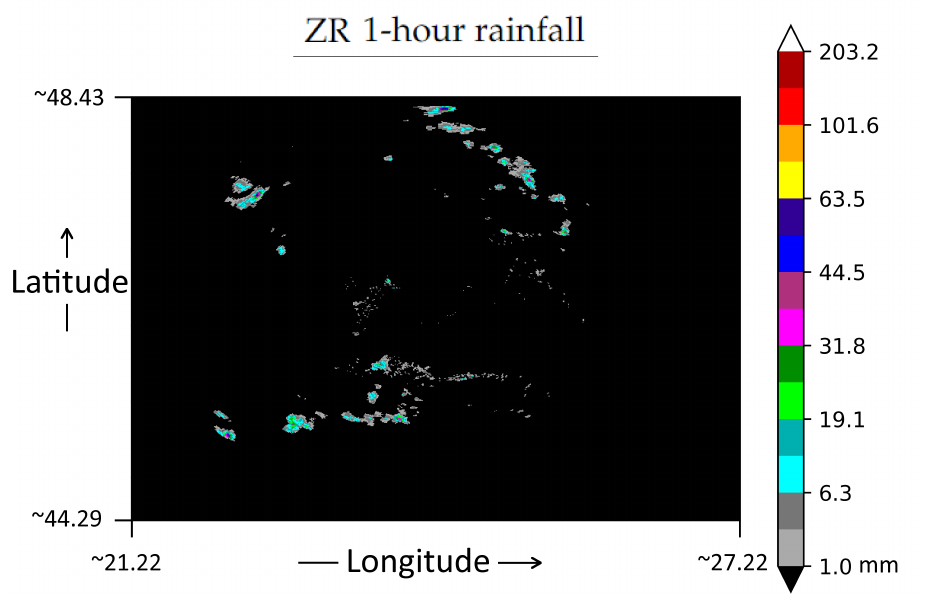
Figure 9. The 1-h rainfall estimation, in millimeters, using ZR for 27 June 2016 at 18:59.